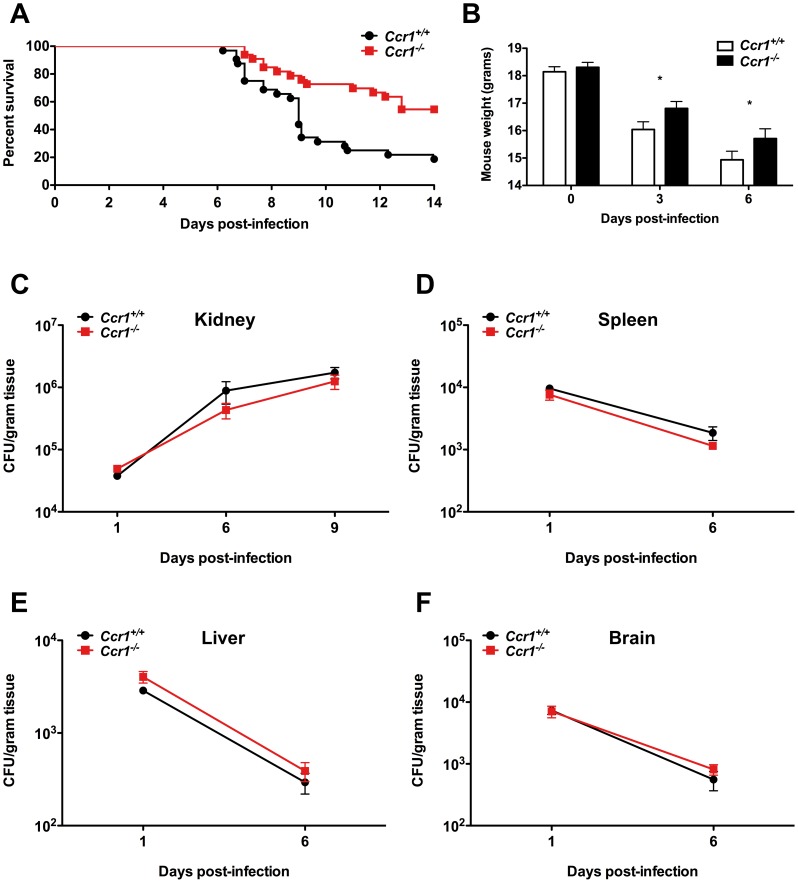
Lack of Ccr1 improves survival without affecting tissue fungal burden in a mouse model of invasive candidiasis.(A) Ccr1−/− mice have 3-fold better survival compared to Ccr1+/+ mice. P = 0.0008. Data are from three independent experiments with a total of thirty-two Ccr1+/+ and thirty-three Ccr1−/− mice. (B) Ccr1−/− mice develop less severe weight loss compared to Ccr1+/+ mice after Candida infection. *
P<0.05. Data are from three independent experiments using twenty-four Ccr1+/+ and twenty-one Ccr1−/− mice. (C–F) Ccr1 deficiency does not affect tissue fungal burden in kidney (C), spleen (D), liver (E) or brain (F). Data are from four independent experiments using twenty-four Ccr1+/+ and twenty-one Ccr1−/− mice. Inoculum, 1.25×105 CFU.